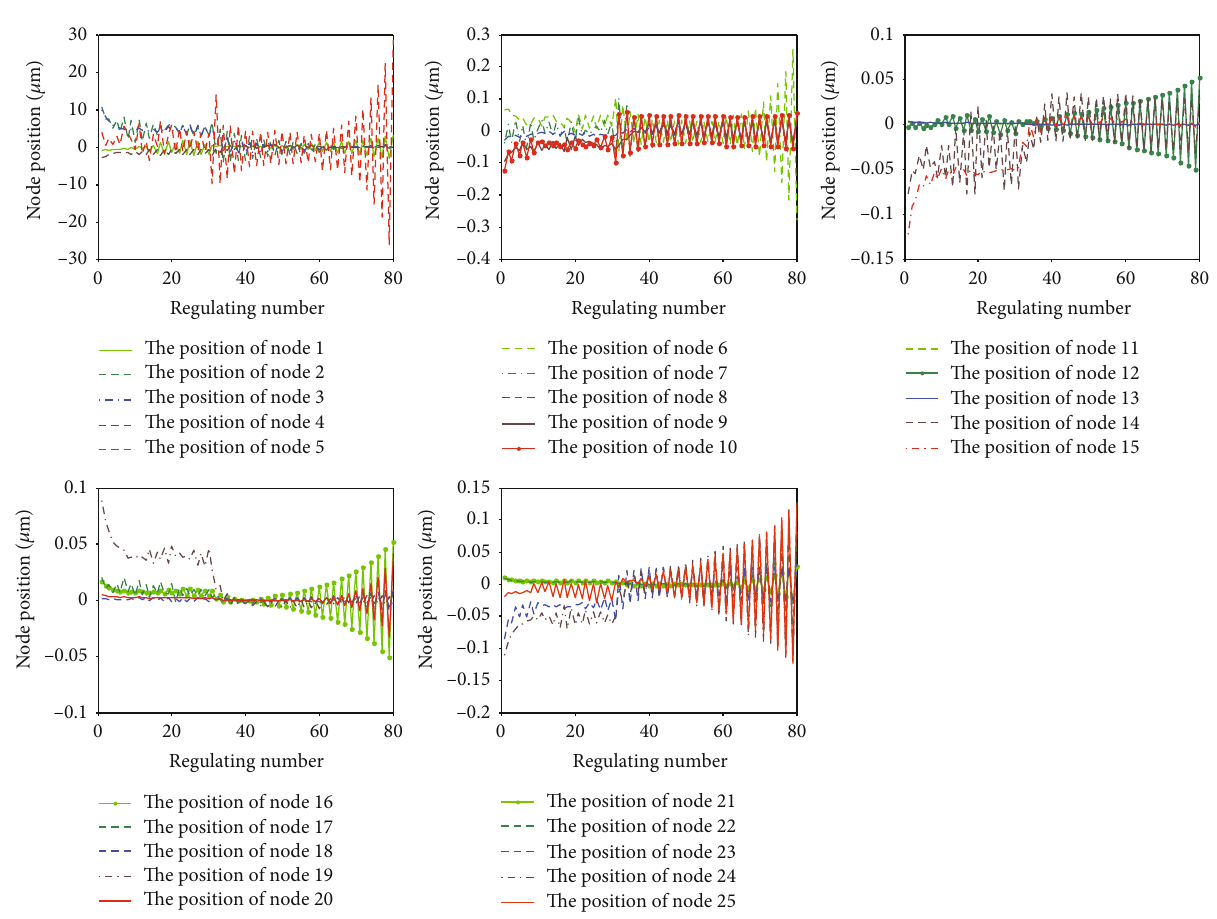
Figure 7: Q-learning adjustment curve with a disturbance of